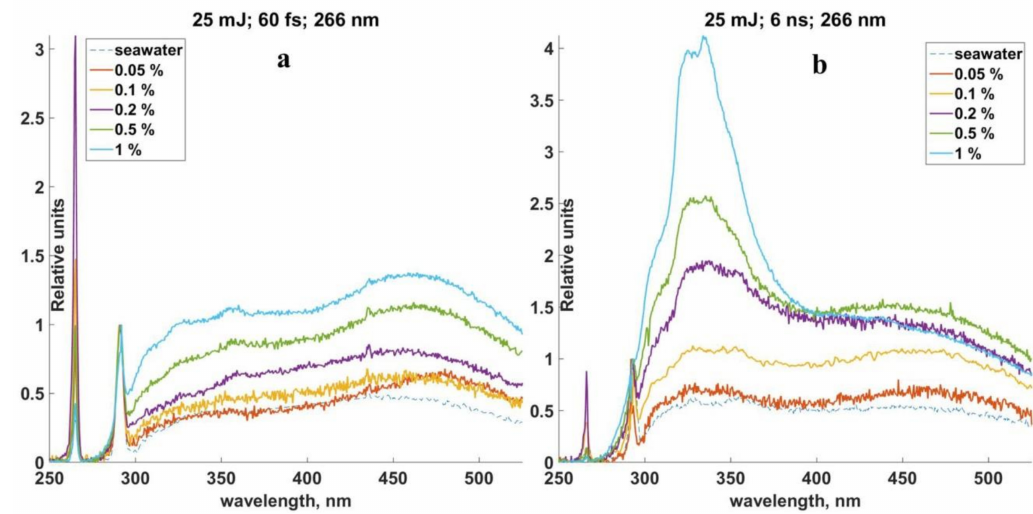
Figure 5. LIF spectrums of crude oil solution in seawater. ( a ) femtosecond LIF; ( b ) nanosecond LIF.